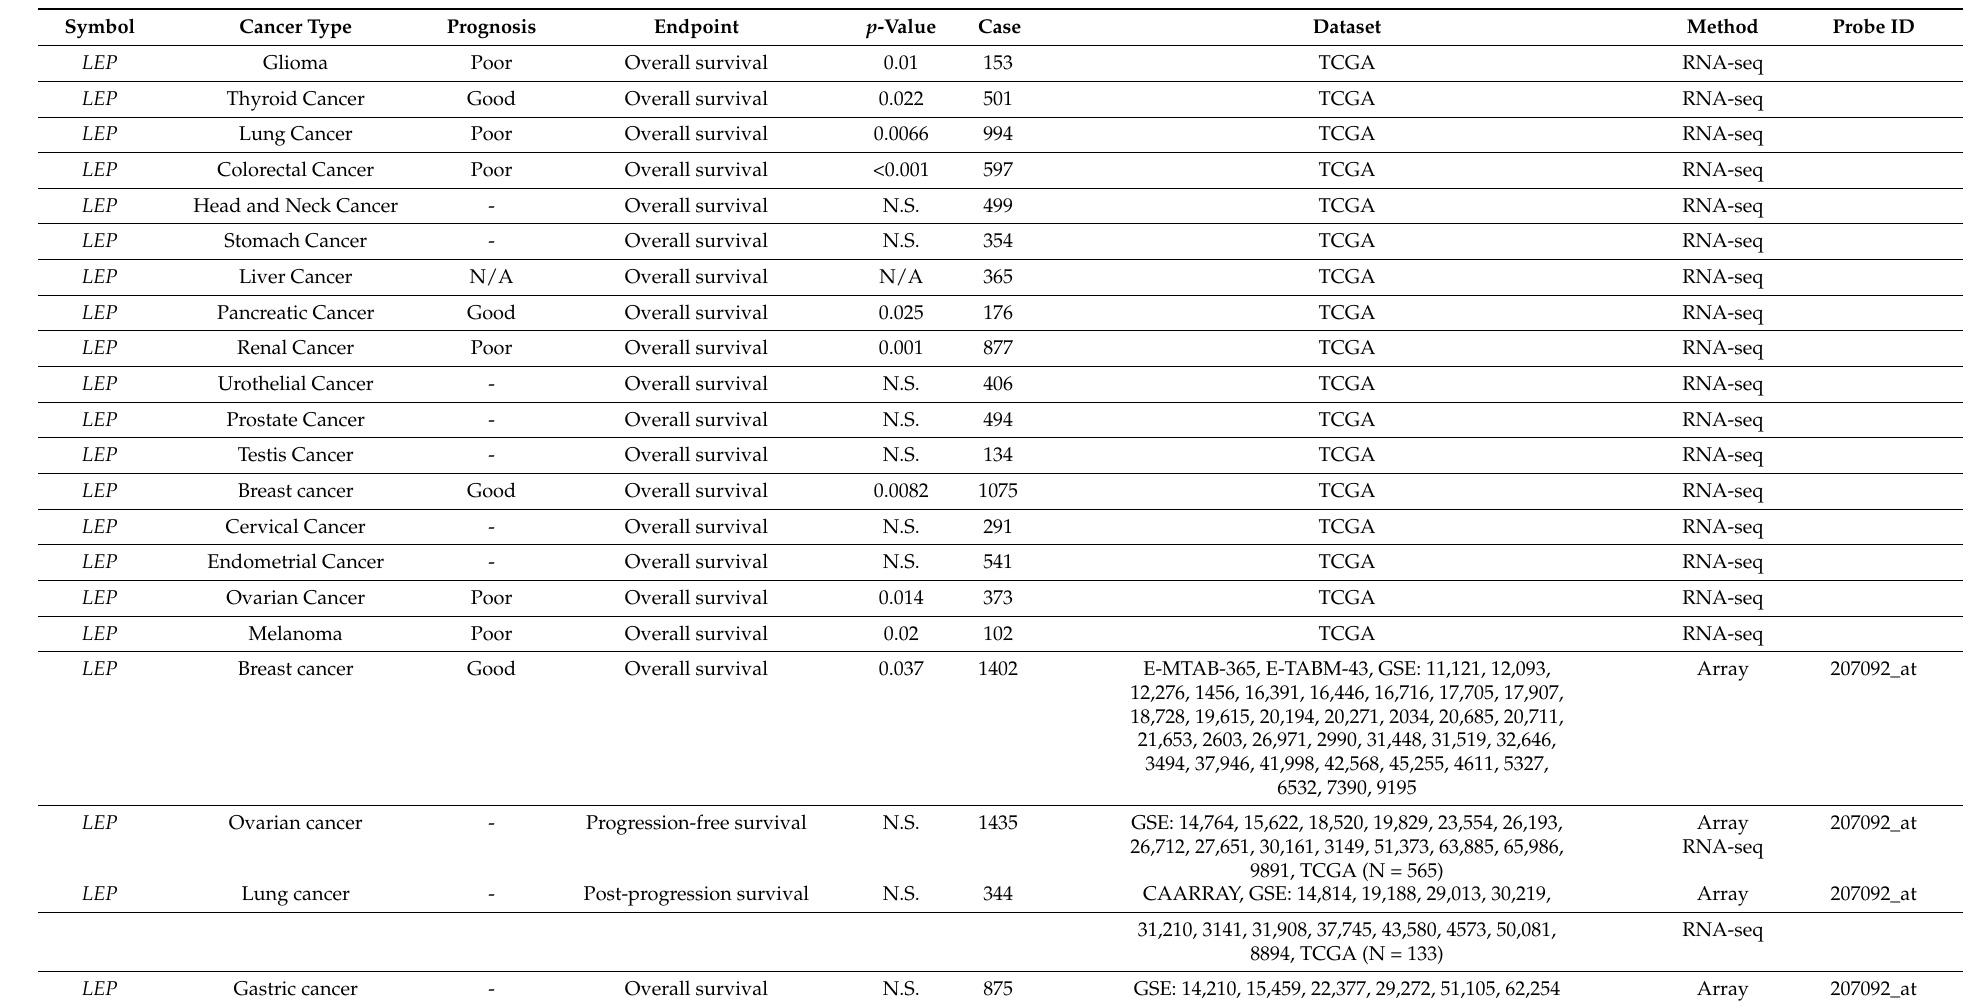
Table 3. Correlation of LEP with cancer patient